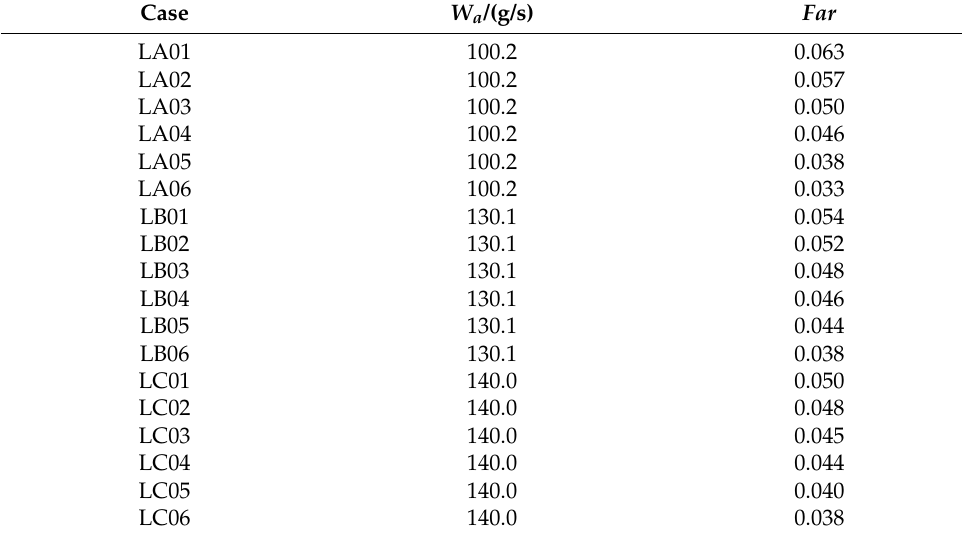
Table 2. Test conditions of the L